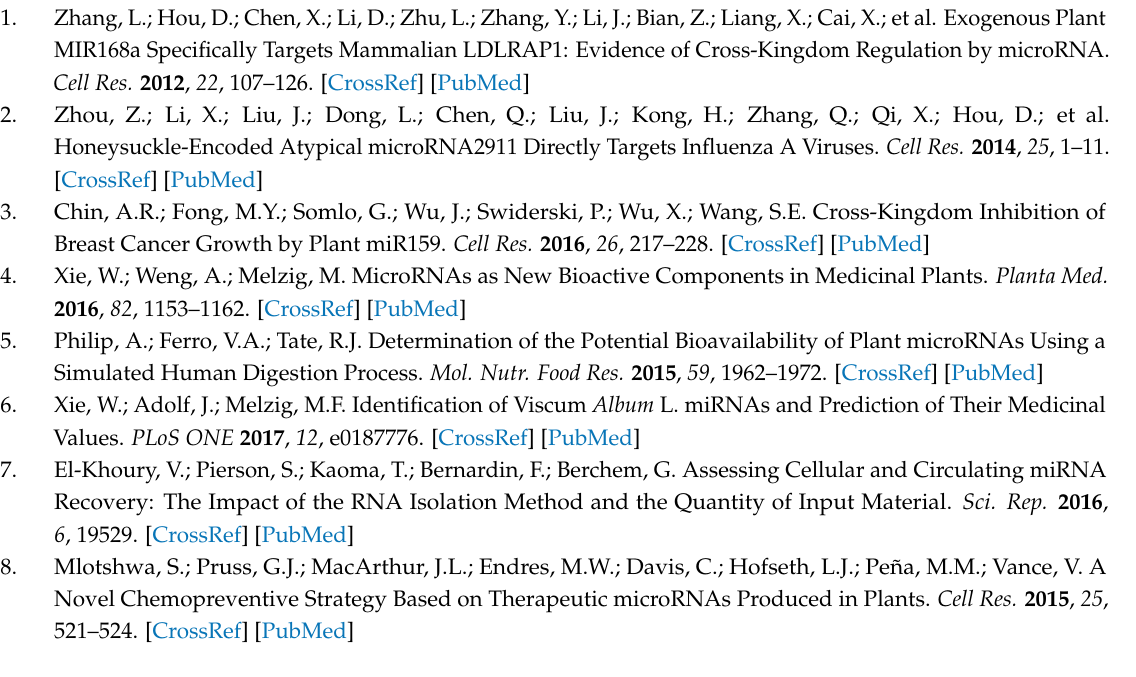
Supplementary Materials: Supplementary materials are available online. Figure S1: Standard curves generated in qRT-PCR